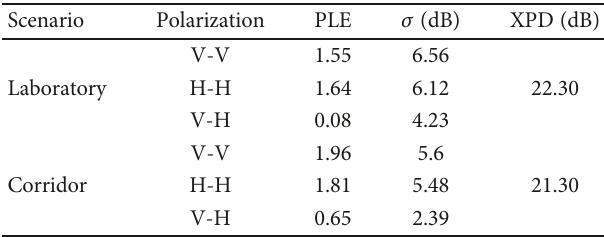
Table 2: PLE values for each polarization in the corridor and in the